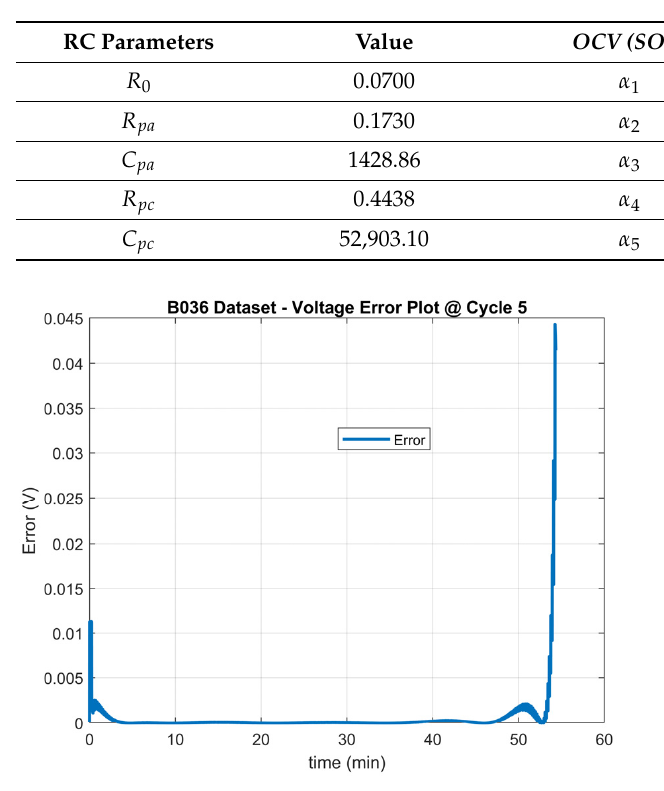
Figure 4. B036 model: LS model error—terminal voltage.